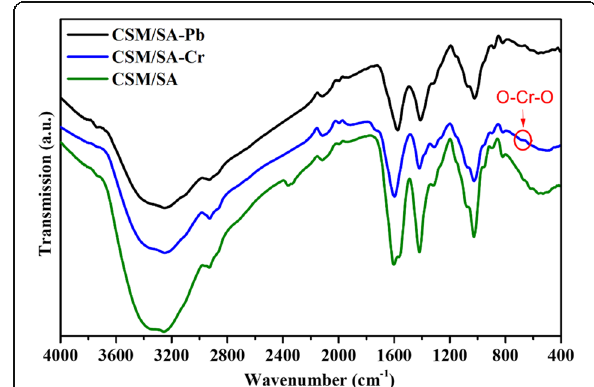
Fig. 2 ATR-FTIR spectra of CSM/SA hybrid beads, (CSM/SA-Pb) CSM/ CA hybrid beads loaded Pb(II) and (CSM/SA-Cr) CSM/CA hybrid beads loaded